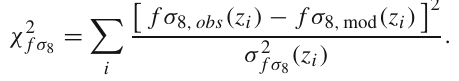
Table 1 The observational data of S 8 ≡ σ 8 , 0 ((cid:6) m 0 / 0 . 3 ) 0 . 5 . See the Refs. for details Survey S 8 Ref. Survey S 8 Refs. HSC 0 . 780 + 0 . 030 − DES (g.c.+w.l.) 0 . 773 + 0 . 026 − KiDS-450 (c.f.) 0 . 745 ± 0 . 039 KiDS-450 + 2dFLenS